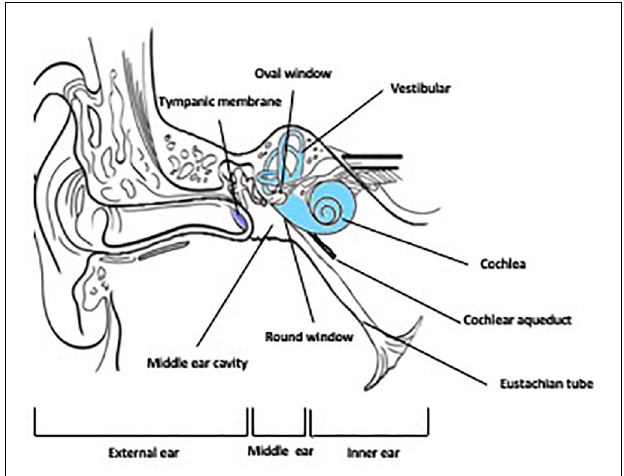
FIGURE 1 | Anatomy of the ear.